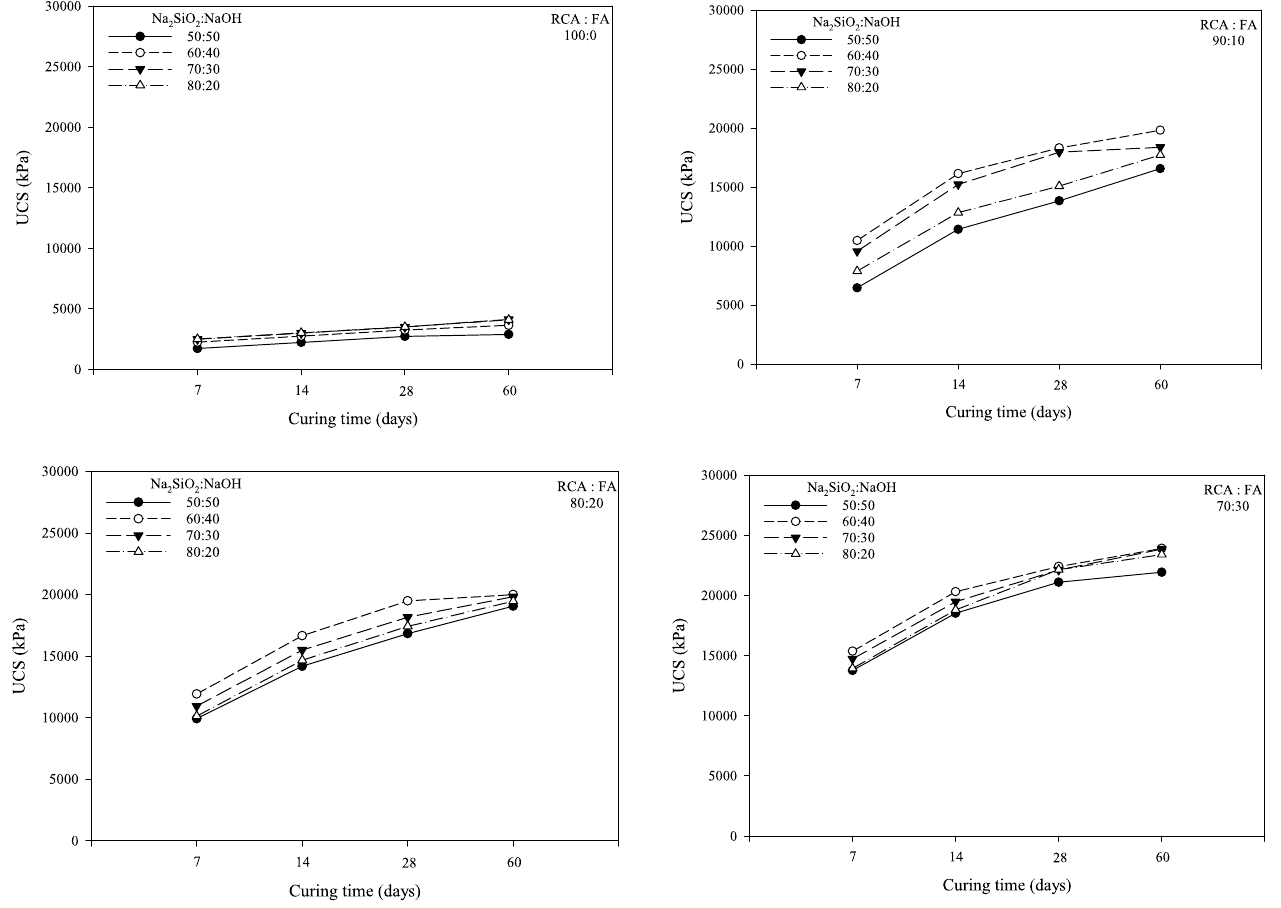
Figure 4. The UCS development in RCA-FAG samples.